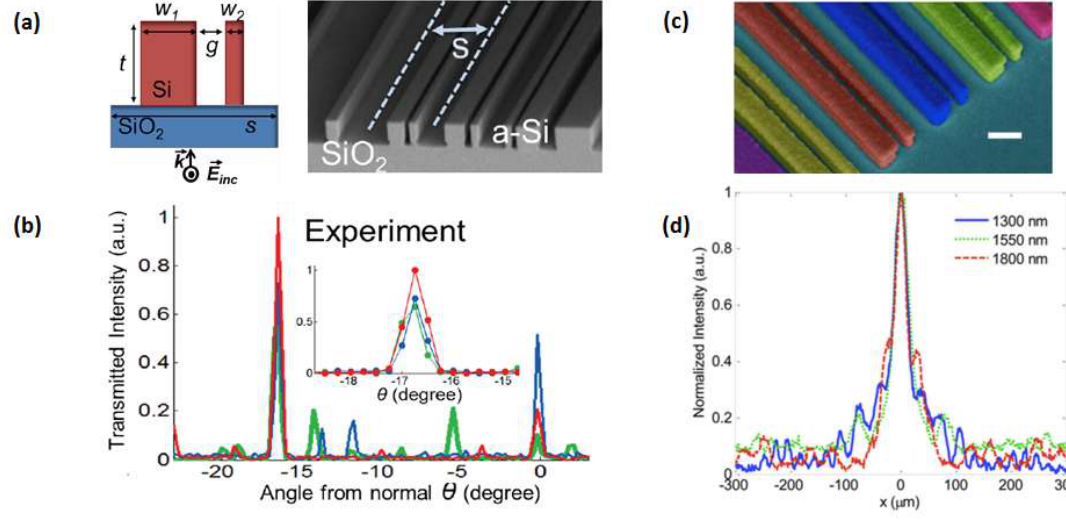
Figure 8: From [182]: An achromatic beam deflector preserves its functionality (i.e. focusing) for different wavelengths, i.e. multiple dis- tinct wavelengths are anomalously refracted at the same angle. (a) Schematic and SEM of the achromatic metasurface design, comprising of near-field coupled resonators of different thicknesses. Here s = 1000 nm, t = 400 nm, w 1 = 300 nm, w 2 = 100 nm and g = 175 nm. (b) Mea- sured far field intensities as a function of incidence angle (from normal) for light at three discrete wavelengths of 1300 nm, 1550 nm and 1800 nm (color coded blue-green-red respectively). The beams coincide at the desired order (here approximately -17 degrees). From [183]: (c) False color SEM and (d) experimentally measured intensity profiles across the focal plane of an achromatic lens for three wavelengths of 1300, 1550, and 1800 nm. Scale bar: 400 nm. Reprinted with permission from Ref. [182], [183]. Copyright 2015 American Association for the Advancement of Science, 2015 American Chemical